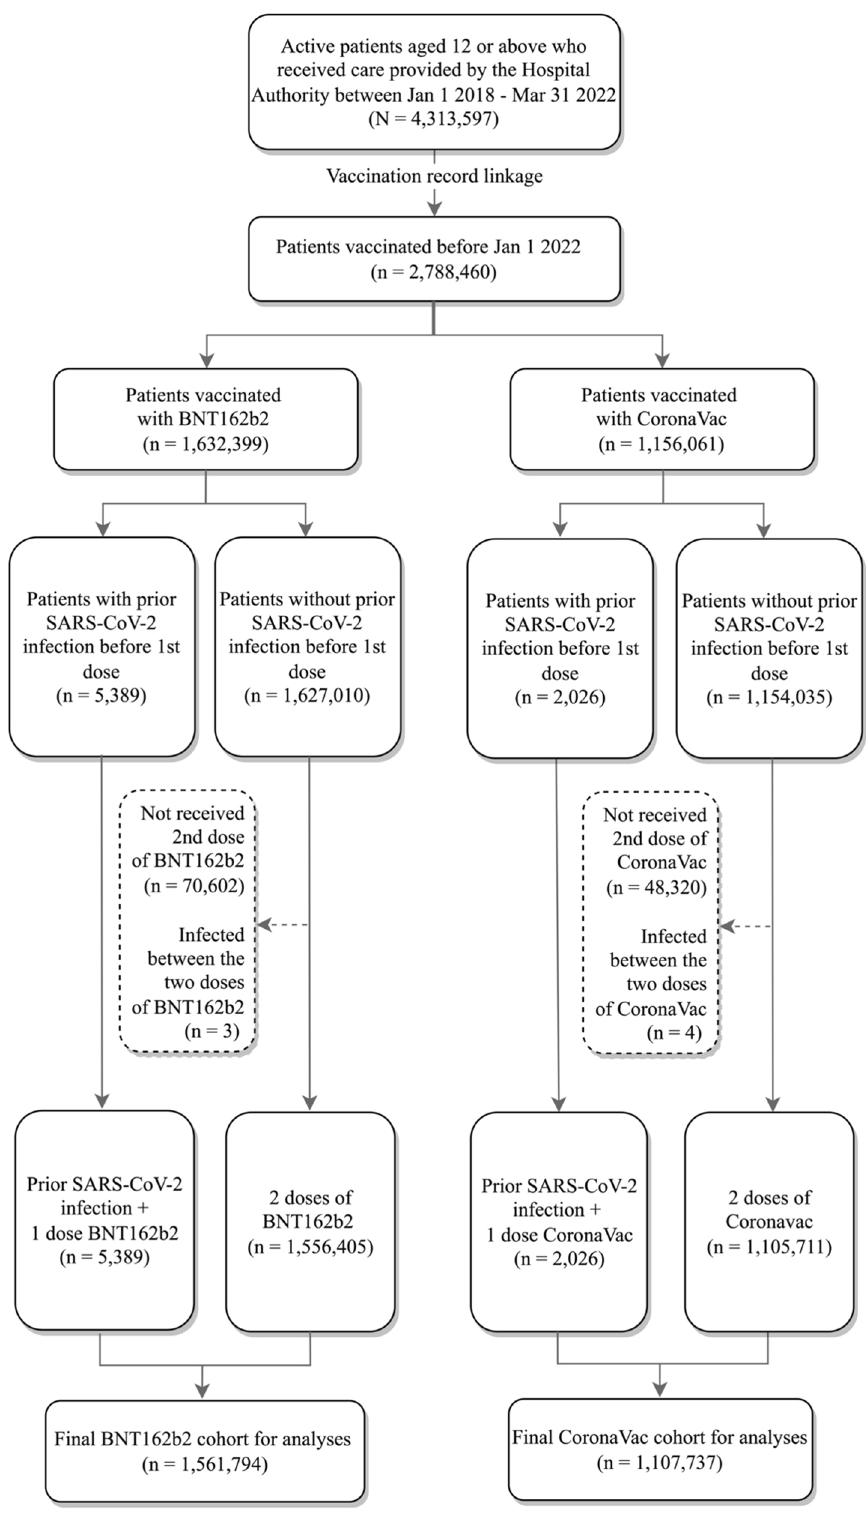
Fig. 1 Cohort selection process. Boxes with dotted borders represent excluded previous infection had lower risk of infection compared with two dose recipients without any previous infection 26 . Existing data mostly focused on the antibody levels rather than COVID-19- related infection, hospitalization, and mortality. We were only able to identify several studies investigating the risk of SARS-CoV-2